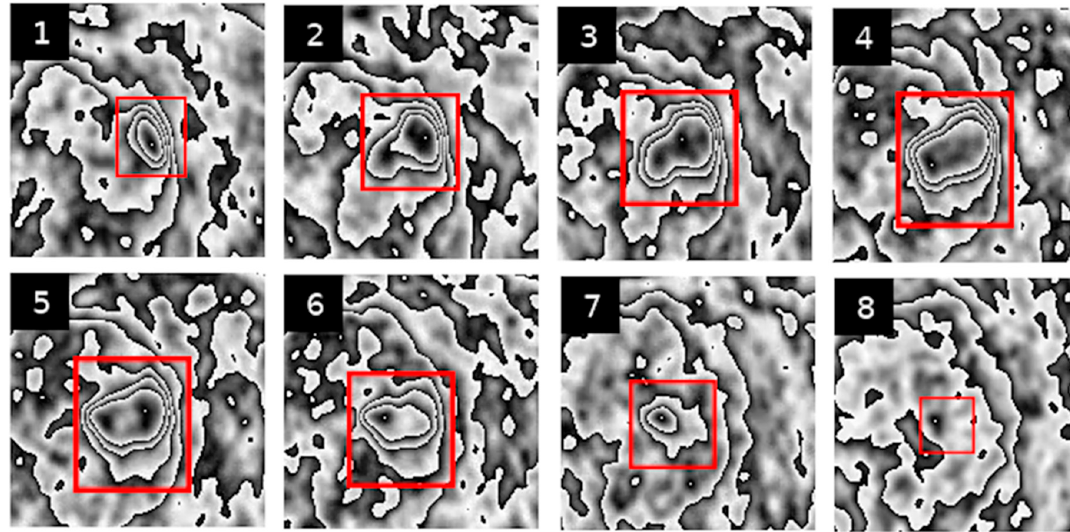
Figure 2. Result of the transformation of PET image sequences using the PCUL-FDG method. The red square indicates the site of a malignant hypermetabolic pulmonary nodule (Figures 1–6 show successive slices of a lung nodule).